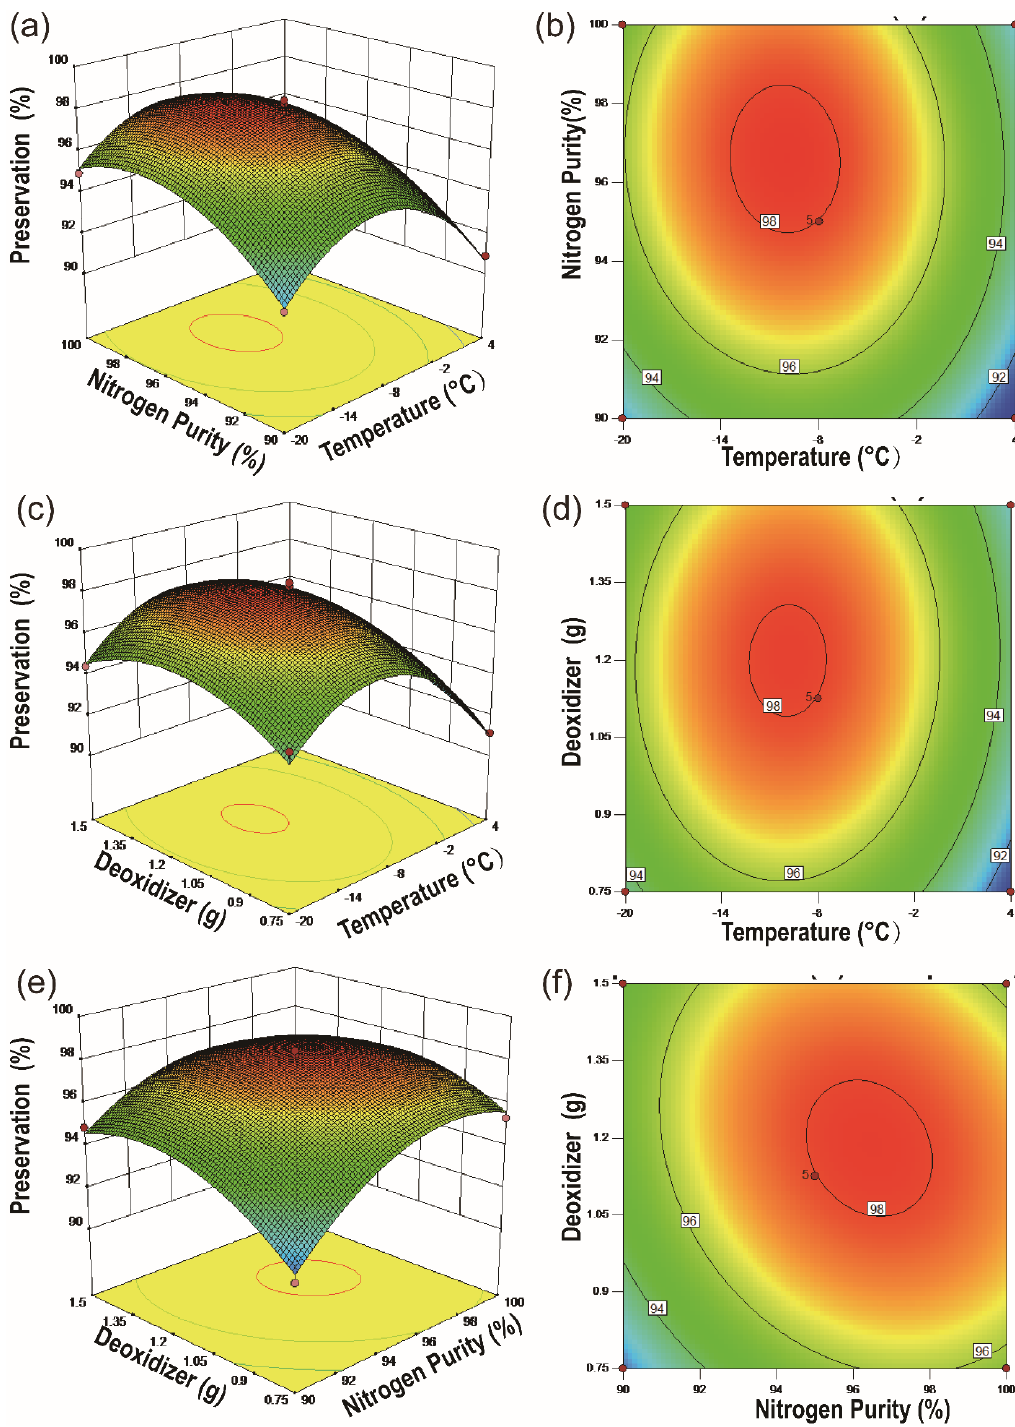
Figure 3. Response surface of Cap-NO·H 2 O preservation (temperature, nitrogen purity): ( a ) surface plot; ( b ) contour plot. Response surface of Cap-NO·H 2 O preservation (temperature, deoxidizer): ( c ) surface plot; ( d ) contour plot. Response surface of Cap-NO·H 2 O preservation (nitrogen purity, deoxidizer): ( e ) surface plot, ( f ) contour plot.